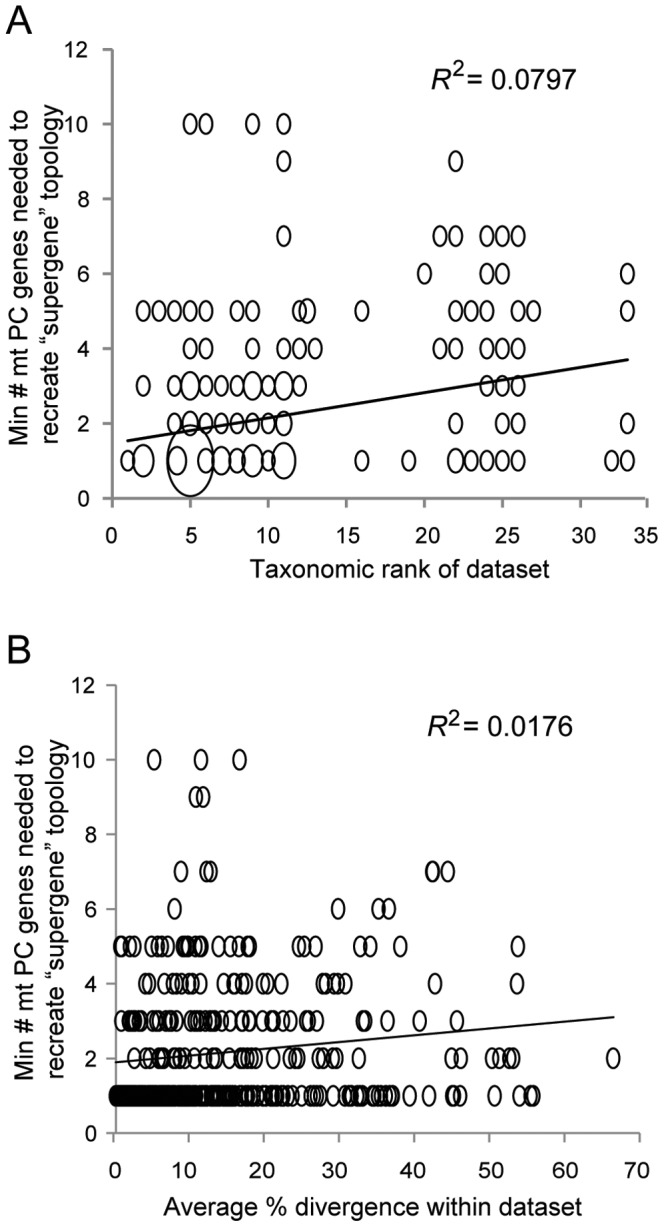
The minimum number of mt protein-coding (PC) genes required to infer the phylogenetic topology of the “supergene” set as a function of taxonomic rank and average % divergence.A) The number of mt protein-coding (PC) genes minimally required for inferring a statistically indistinuishable topology to that of the “supergene” set (i.e., all 13 mt PC genes) as a function of taxonomic rank of the lineage/dataset. A taxonomic rank of “1” along the x-axis corresponds to a within species phylogeny, “2” corresponds to within genus, etc. Subphylum was the highest rank analyzed, being assigned a taxonomic rank of 33. Taxonomic rank of each lineage followed the convention of NCBI as indicated in Dataset S1. The minimum number of mt protein-coding genes presented here are for phylogenies that utilized amino acid data and were inferred via maximum likelihood. Symbols of larger sizes represent of multiple datasets, with size being porportional to number of datasets. B) The number of mt protein-coding (PC) genes minimally required for inferring a statistically indistinuishable topology to that of the “supergene” set (i.e., all 13 mt PC genes) as a function of average % divergence of the lineage/dataset. The average % divergence was calculated using infoalign in EMBOSS. Minimum number of mt protein-coding genes presented here are for phylogenies that utilized amino acid data and inferred via maximum likelihood.